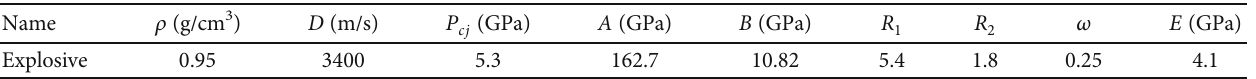
Figure 11: The vertical dimension and charging structures of the bedrock model. Table 6: Explosive parameters.